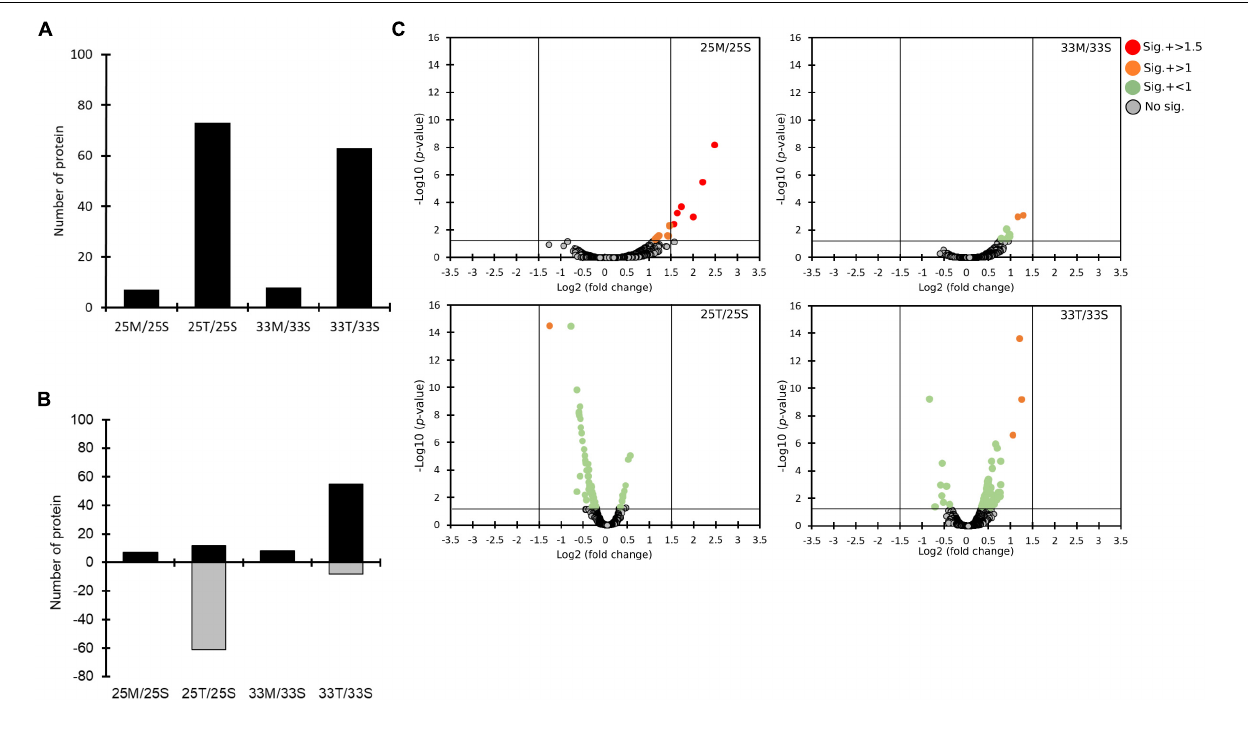
FIGURE 4 | The quantitative proteomics analysis comparing the effects of different coral lysates (25M/25S, 25T/25S, 33M/33S, and 33T/33S). (A) Bar plots on counts of significantly changed proteins. (B) The numbers of proteins with increased (black) and decreased (gray) expression. (C) The distributions of statistical significance [-log 10 ( p -values)] and magnitude of change (Log 2 fold change) for all the proteins in four different comparisons represented by volcano plots. The proteins for which there was no significant difference are marked in gray circles. Significantly changed proteins are marked in different colors based on different levels of log 2 fold change. (red: log 2 fold change > 1.5, orange: log 2 fold change > 1, and green: log 2 fold change <